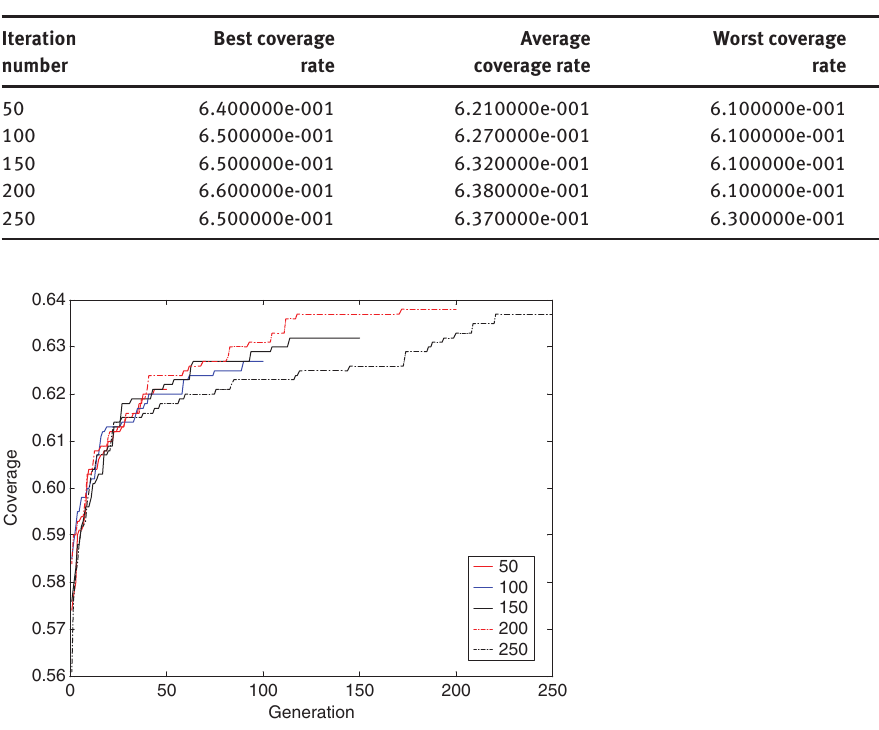
Table 2: The Statistical Results about the Influence of the Iteration Number on Coverage Performance.